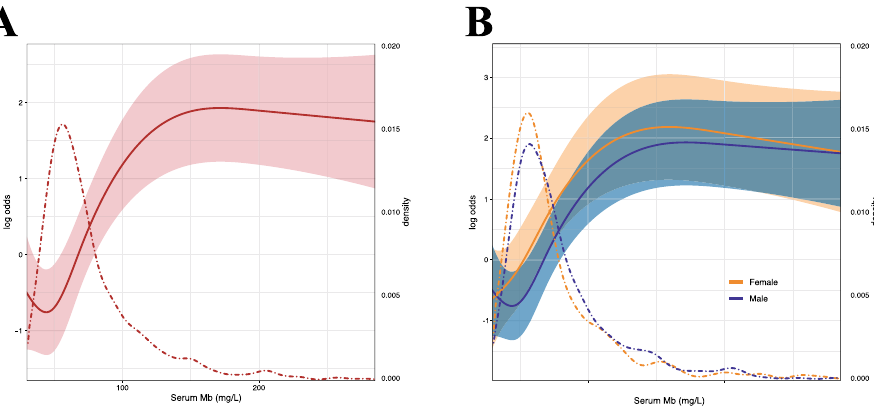
Figure 4. Restricted cubic spline models for log odds ratios of DKD versus serum Mb on a continuous scale. Analyses were adjusted for gender, age, BMI, hyperlipidemia, hypertension, ACCI, and hospitalization date. ( A ) The red solid line is the multivariable adjusted log odds ratio, and the shaded area shows the 95% confidence interval derived from restricted cubic spline regressions with four knots. The red dashed curve represents the distribution density of the population with different serum Mb levels. ( B ) The orange and blue solid lines are the multivariable adjusted log odds ratio for female and male subgroups, respectively, and the shaded areas show the 95% confidence intervals derived from restricted cubic spline regressions with four knots. The orange and blue dashed curves show the distribution density of populations with different serum Mb levels in female and male subgroups, respectively.